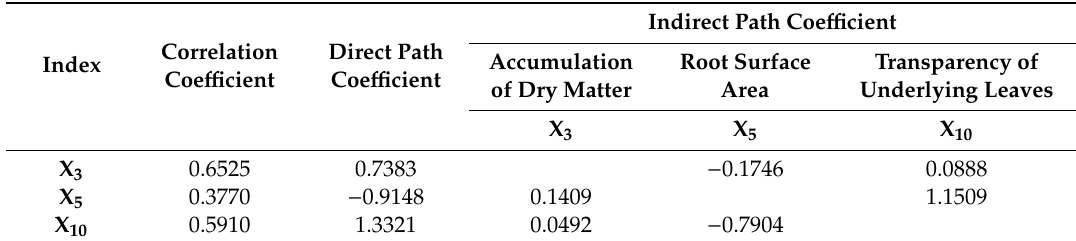
Table 5. Results of the path analysis of the indices and yield of high-yielding spring maize under rotary